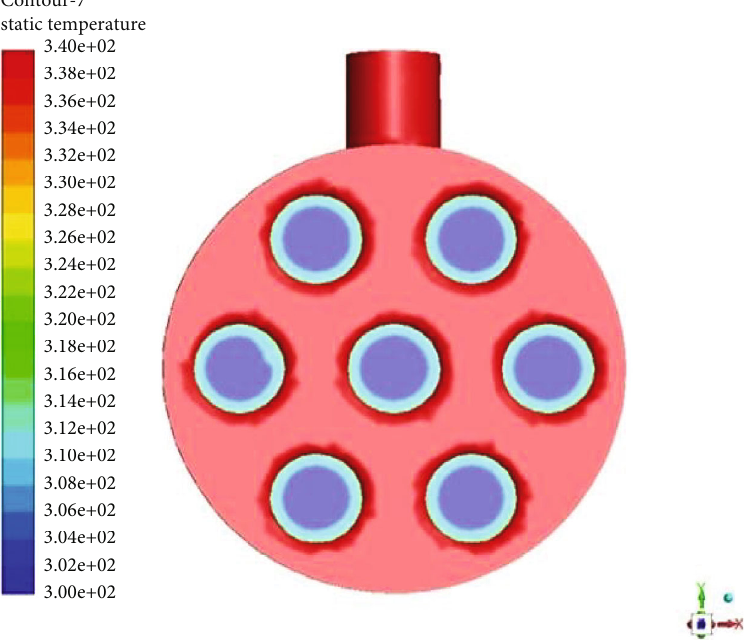
Figure 6: Temperature contour with 1% nanoparticle addition.